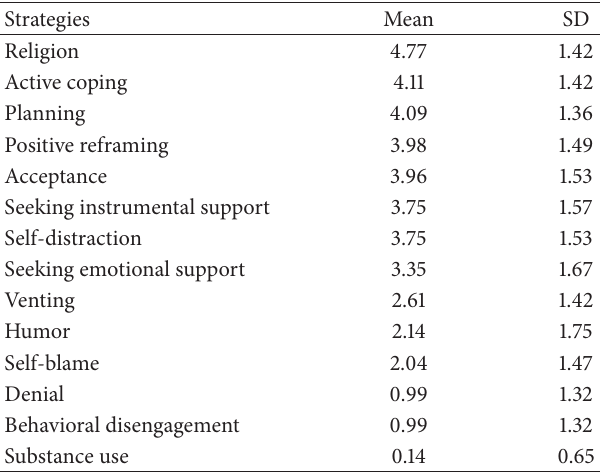
Table 1: Mean and standard deviation of the behavioural coping